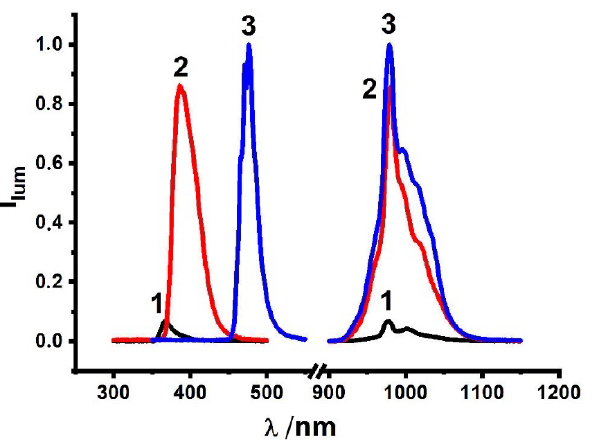
Figure 9. Excitation and emission spectra of Yb 3+ complexes with H 4 L ( 1 – 3 ) in the present TEA in DMF solutions.